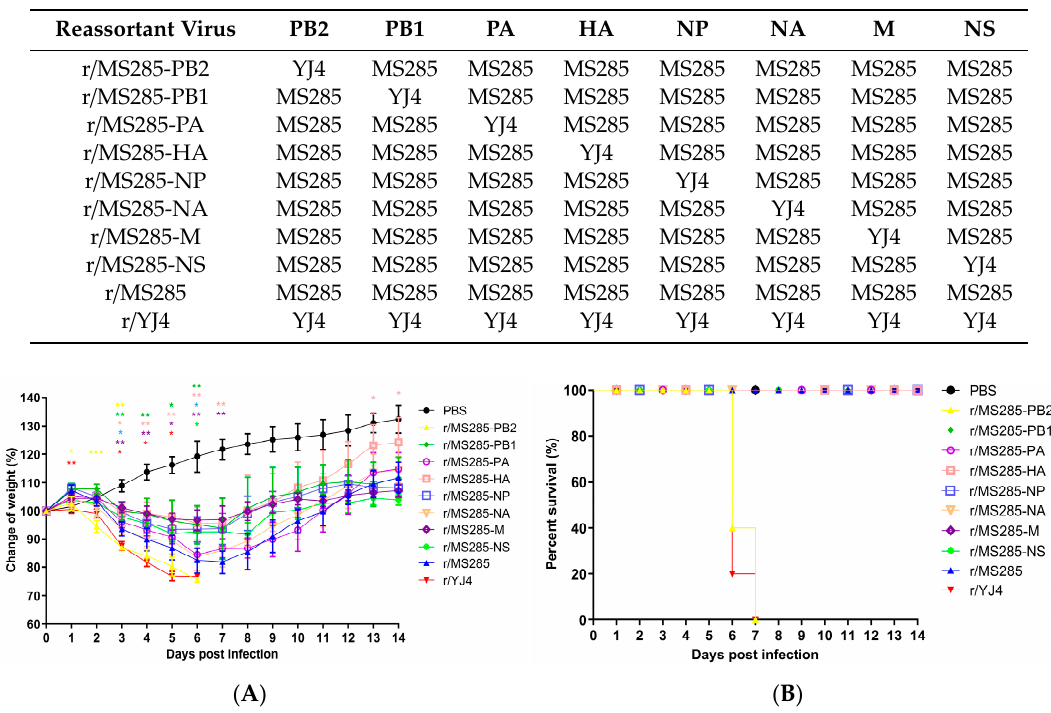
Table 2. Gene source of the single fragment reassortant influenza viruses.